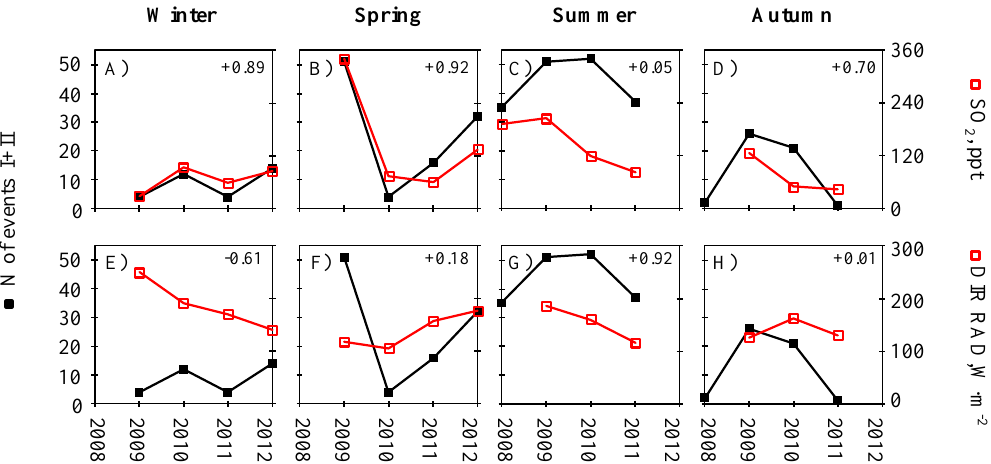
Fig. 12. Number of banana-type events (I + II) and mean values (11:00–16:00GMT) of SO 2 and direct radiation per season for the period June 2008–June 2012 at Izaña: winter (Jan–Mar), spring (Apr–Jun), summer (Jul–Sep) and autumn